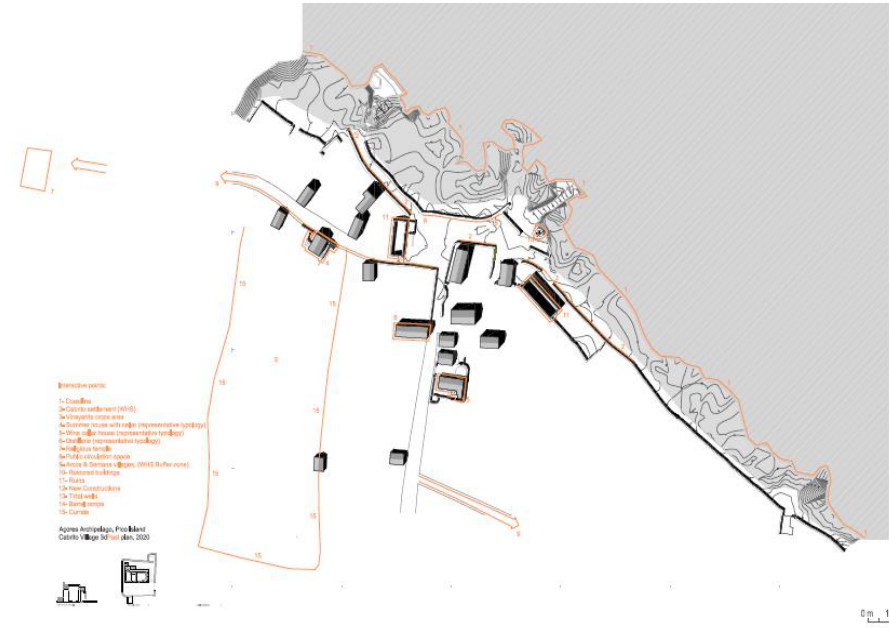
Figure 4. Plan of Cabrito settlement. Source: 3dPast Research project. Ci-ESG, Escola Superior Gallaecia,